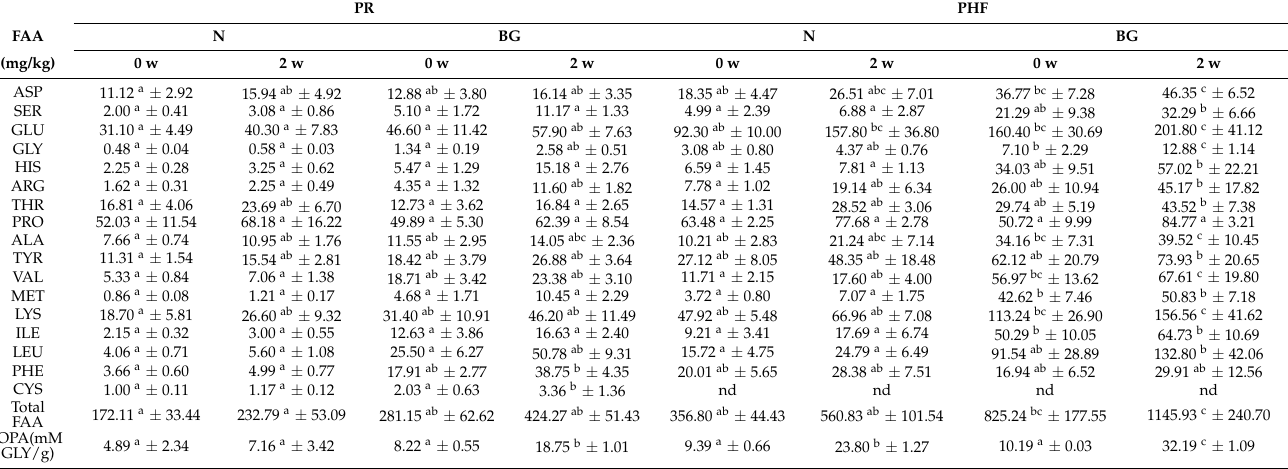
PR—milk from Polish Red cows, PHF—milk from Polish Holstein-Friesian cows, N—natural cheese without herbs, BG—cheese with bear garlic, FAA—Free amino acids; OPA—0 w—fresh cheese at week 0, 2 w—stored cheese at week 2; nd—not detected; abc Different letters denote statistically significant differences between means at p ≤